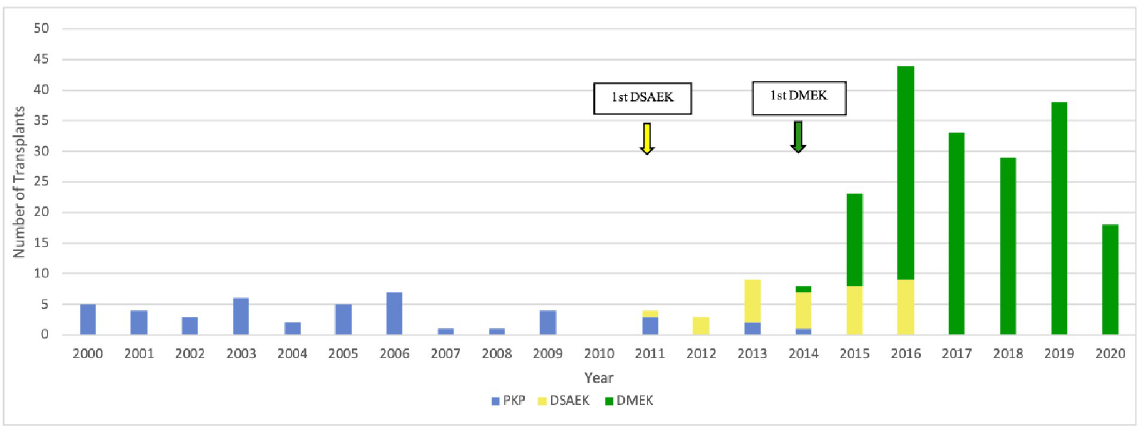
Fig 4. Changes over time in the type of surgery used for FECD. DSAEK, Descemet stripping automated endothelial keratoplasty; DMEK, Descemet membrane endothelial keratoplasty; FECD, Fuchs endothelial cell dystrophy; PKP, penetrating